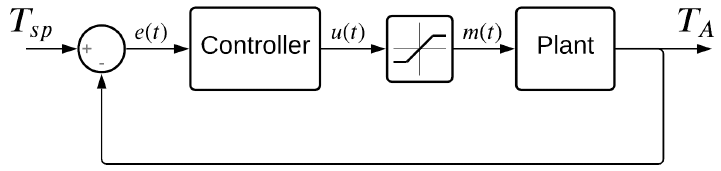
Figure 3. Closed-loop controller for variable speed heat pump.